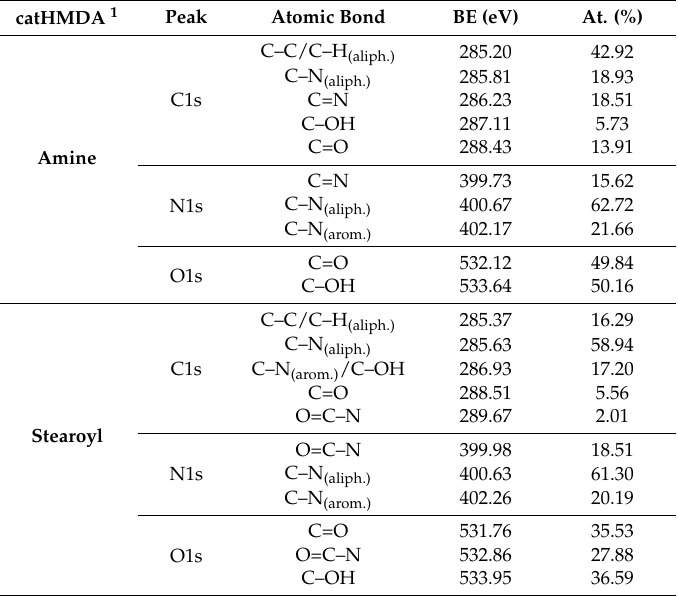
Table 2. Curve-fitting assignments corresponding to C1s, N1s and O1s peaks for catHMDA-16 h/amine and catHMDA-48 h/stearoyl. Table 2. Curve ‐ fitting assignments corresponding to C1s, N1s and O1s peaks for catHMDA ‐ 16 h/amine and catHMDA ‐ 48 h/stearoyl.